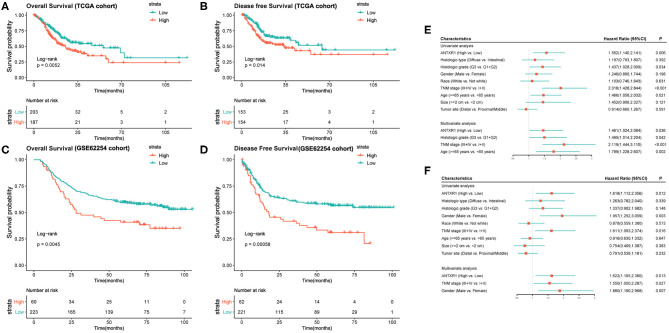
High expression of ANTXR1 predicts adverse clinical outcomes of gastric cancer patients by applying Kaplan–Meier survival analysis. (A,B) Based on TCGA datasets. (C,D) Based on GSE62254 cohort. Univariate and multivariate analysis of clinical parameters associated with overall survival (E) and disease-free survival (F).